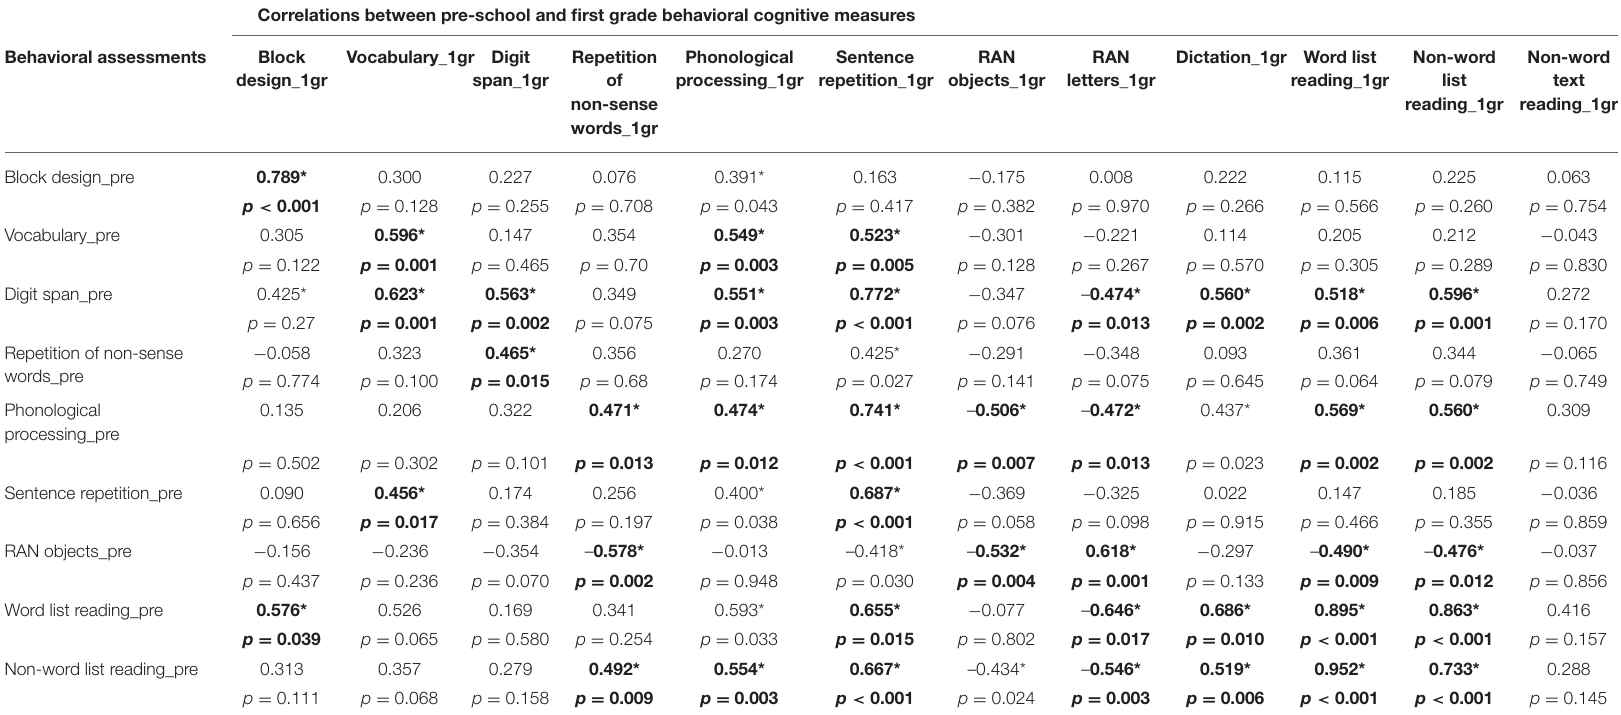
TABLE 4 | Correlations (Spearman’s) between cognitive skills of pre-school and first grade children ( N = 27, 16 Controls & 11 At-risk). Correlations between pre-school and first grade behavioral cognitive